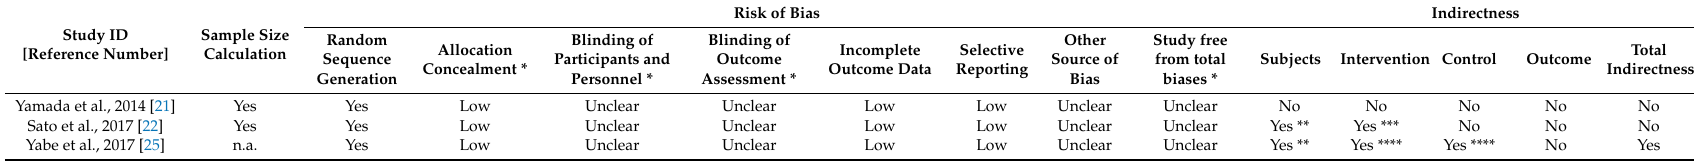
Table 2. Methodological quality and risk of bias of carbohydrate restriction studies (including energy restriction studies as control group